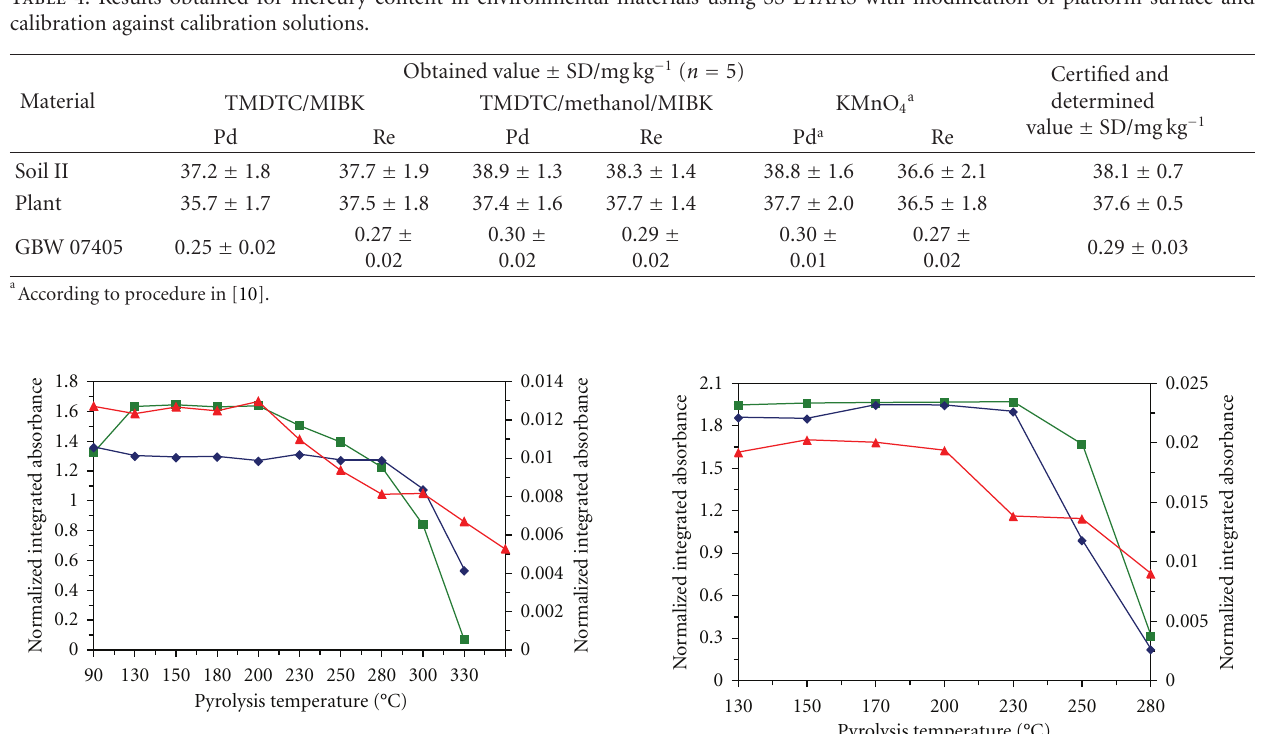
Figure 4: Pyrolytic curves for solid samples in presence Pd surface modifier. left axis: (cid:5) plant, (cid:3) soil II; right axis: (cid:2) CRM CBW 07405.